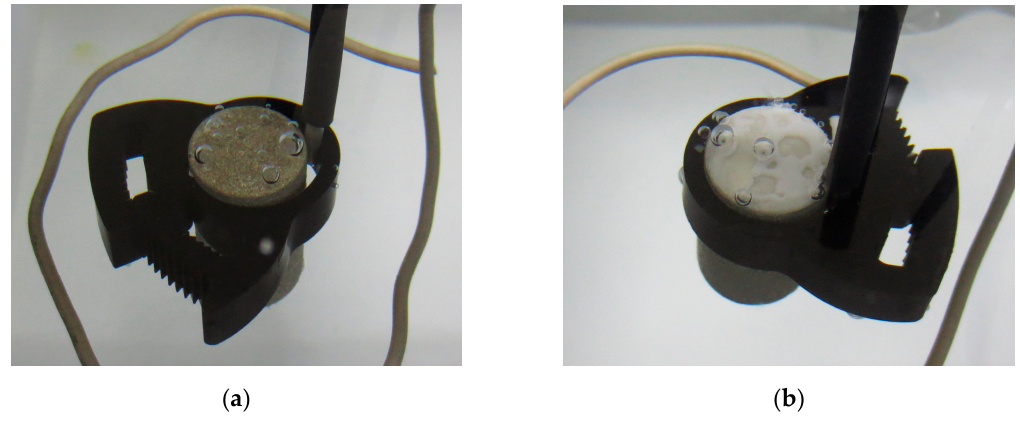
Figure 6. Photographs of samples showing gas bubbles emanating from the surface of: ( a ) TSA-coated specimen; ( b ) uncoated specimen showing white deposit on the top surface. The specimens were 1 cm in diameter and 2 cm in length.